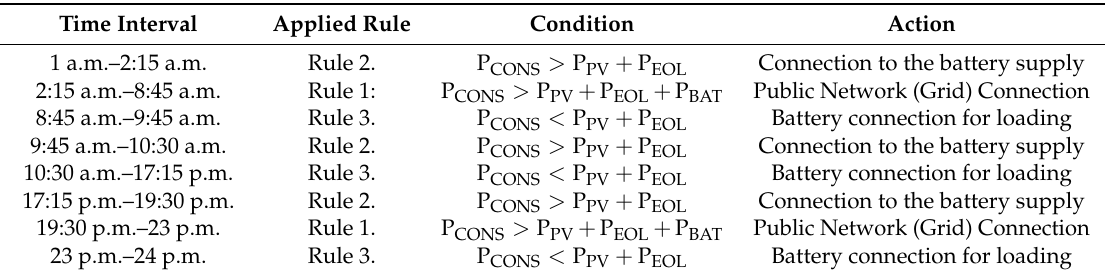
Table 2. Application of DSS decision rules on the simulation case study.